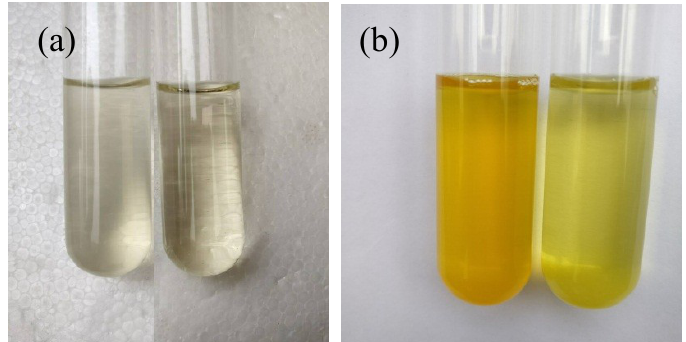
Figure 3. Ammonia test of B. licheniformis DB1‐9 bacteria cultivated for 30 h. ( a , b ) The control group is the culture medium without bacteria (right); the experimental group is inoculated with bacteria (left). ( a ) before adding Nessler’s reagent, ( b ) after adding Nessler’s reagent.